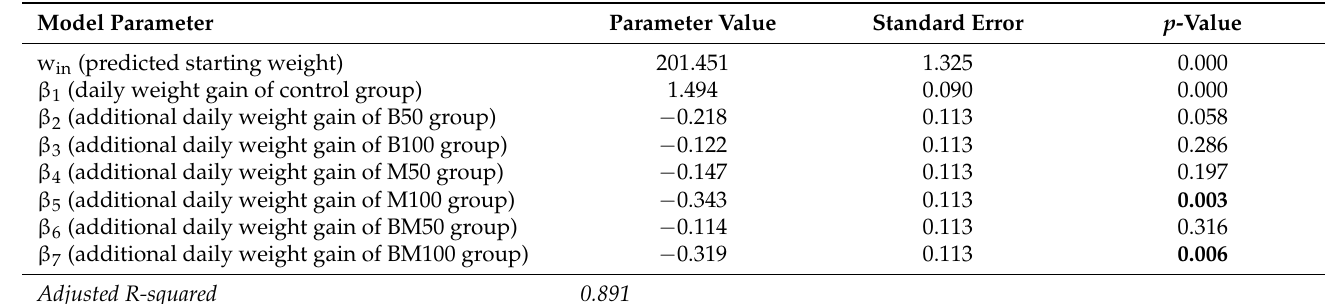
Table A1. Summary of the linear growth model